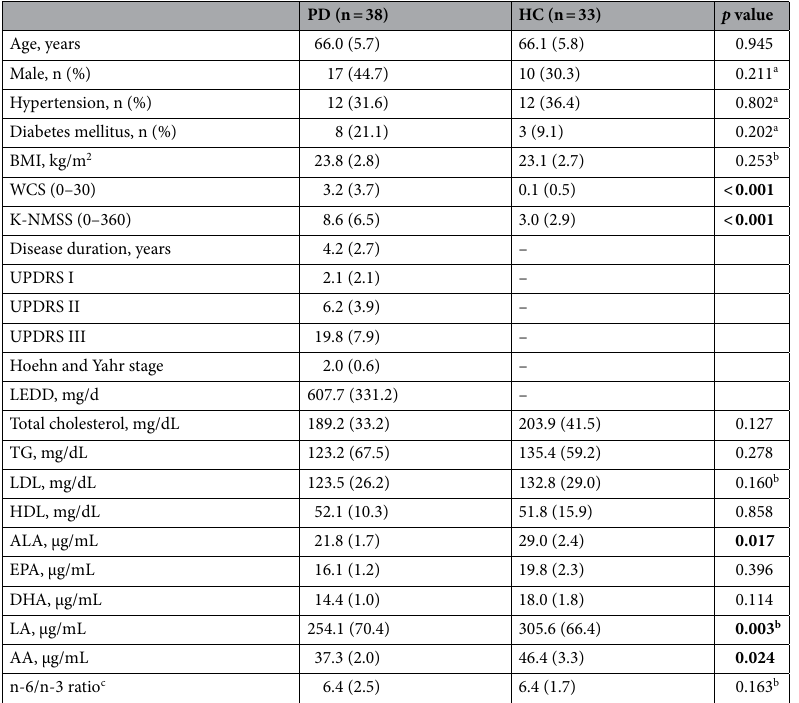
Table 1. Demographic and clinical data of the study participants and their plasma lipid levels. Data are described as mean (standard deviation) or frequency. The p values marked in bold indicate statistically significant differences between the two groups. For group comparisons, the Mann–Whitney U test was used if not otherwise indicated. a Pearson’s chi-squared test; b Student’s t test; c n-6/n-3 ratio = (LA + AA)/ (ALA + EPA + DHA). PD Parkinson’s disease, HC healthy control, BMI body mass index, WCS Wexner constipation score, K-NMSS Korean Non-Motor Symptoms Scale, UPDRS Unified Parkinson’s Disease Rating Scale, LEDD levodopa-equivalent daily dose, TG triglyceride, LDL low-density lipoprotein, HDL high-density lipoprotein, ALA alpha-linolenic acid, EPA eicosapentaenoic acid, DHA docosahexaenoic acid, LA linoleic acid, AA arachidonic